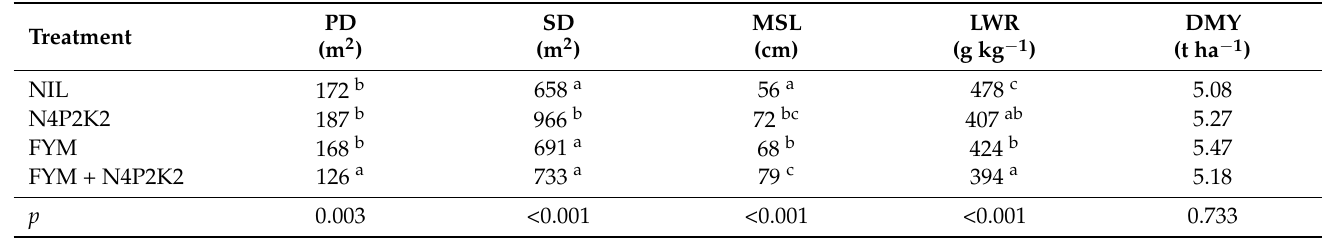
Table 3. Effect of fertilization treatments on evaluated lucerne stand traits (PD = plant density; SD = stem density; MSL = maximal stem length; LWR = leaf weight ratio; DMY = dry matter yield) in the first cut 2014.